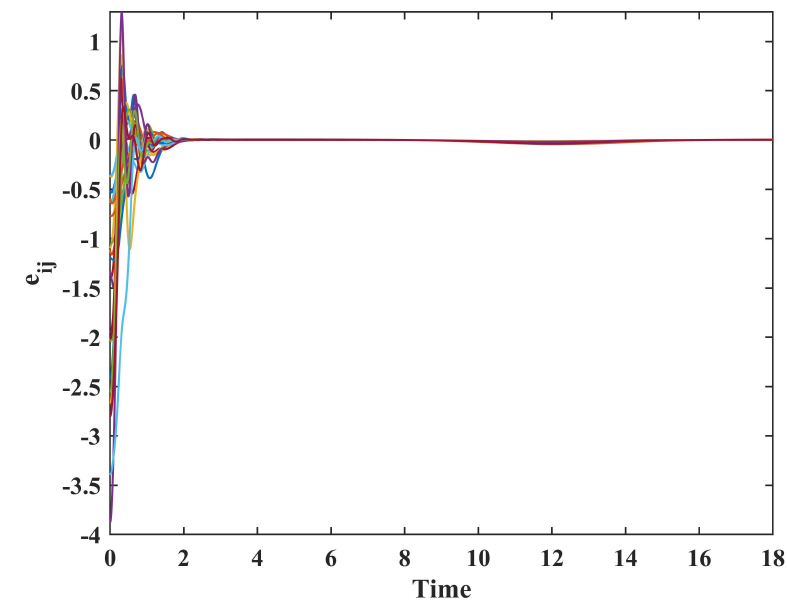
Figure 6. Distance errors between agents i and j